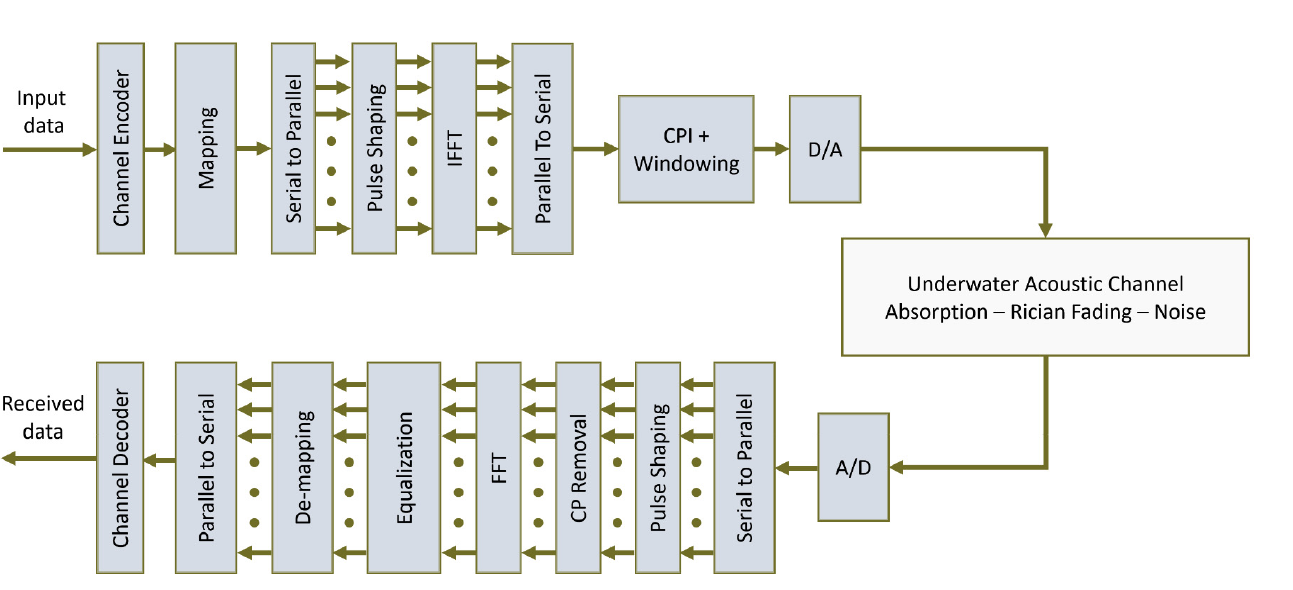
Figure 2. Proposed coded-GFDM transceiver architecture.